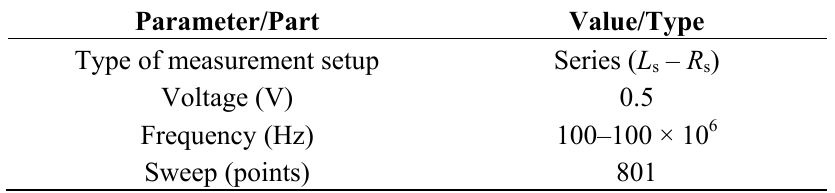
Table 4. Specifications for the frequency characteristics experimental